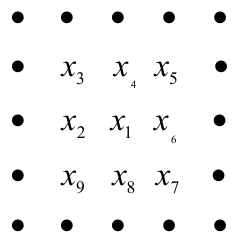
Figure 1. Contextual information.